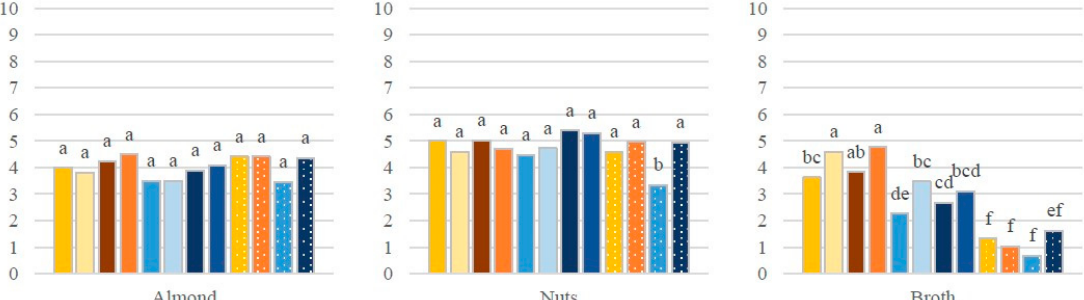
Figure 3. Mean attribute intensities (across replicates and panelists) of the 12 beverages containing different levels of the same ingredients as evaluated using static block profiling (differences in letters indicate significant differences among groups as revealed by the Newman–Keuls post-hoc analysis). Intensity scores could range from 0 to 10. Abbreviations: I = protein from isolate (solid color) , P = protein from pellet (dotted color) , F+ = 1.5% oil content (dark color) , F − = 0% oil content, G+ = 0.5% gellan gum content (blue) , G- = 0.12% gellan gum content (orange) , S+ = 0.12% salt content (light color) , and S − =0.08% salt content.